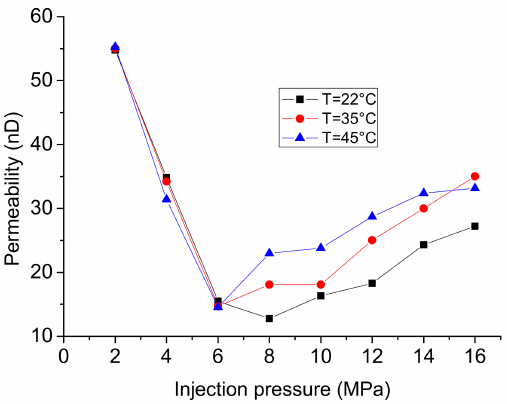
Figure 8. Relationship between the calculated permeability to CO 2 and injection pressure at different